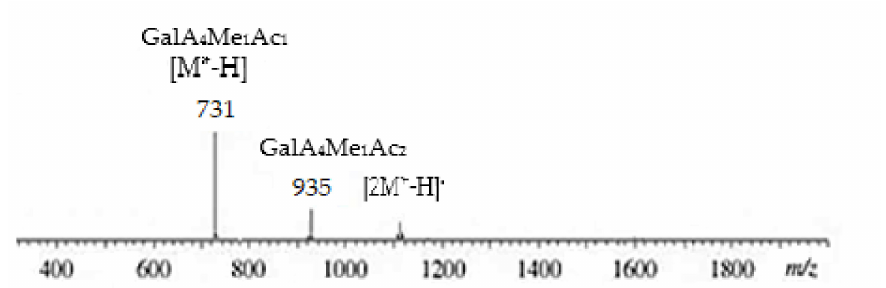
Figure 3. Mass spectrometry of apple pectin